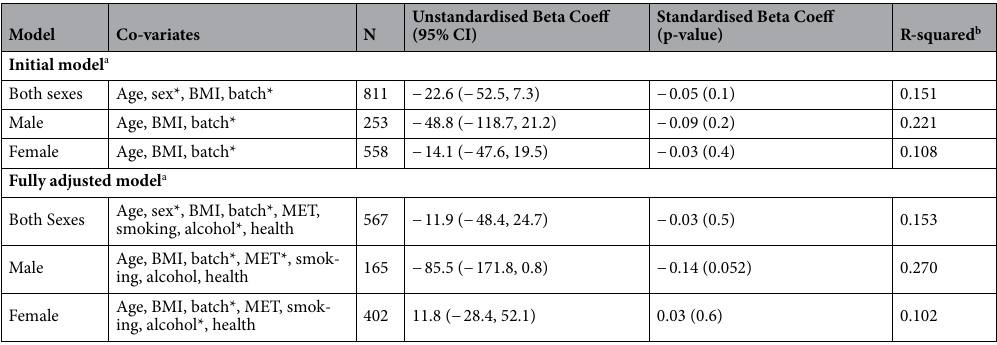
Table 3. NTR multivariable linear regression models (initial and fully adjusted a ) with 3-hydroxybutyrate as the response variable, regression coefficients of aggression rating as predictor variable, with sexes pooled and separated. a Initial model: adjusted for age, sex, BMI, batch, and familial relatedness. Fully adjusted model: adjusted for age, sex, BMI, batch, MET, smoking status, alcohol consumption frequency, self-rated general health, and familial relatedness. b R-squared represents the variation explained from all variables in the model